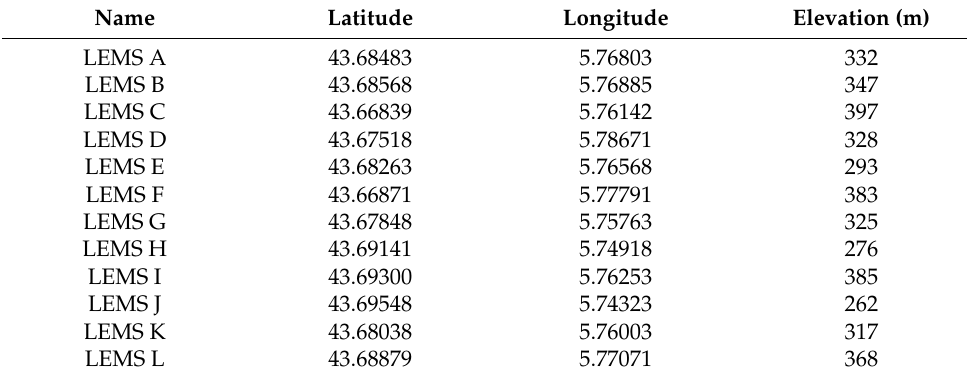
Table 1. Table of LEMS